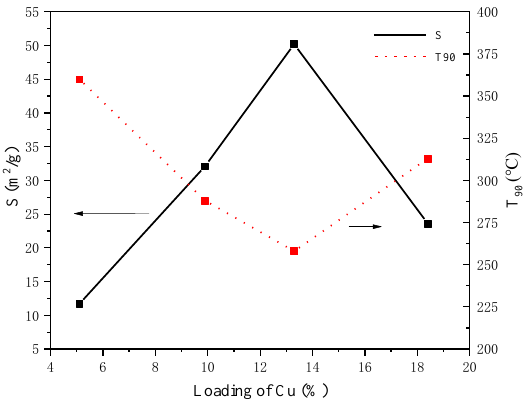
Figure 10. Effect of copper loading over the W% Cu-A-BM catalysts on the copper active surfaces and the T 90 .